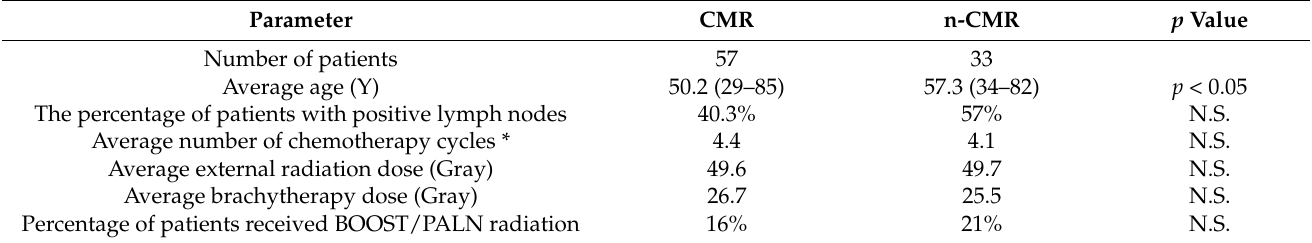
Table 1. Demographic data of CMR and n-CMR groups. CMR—complete metabolic response,